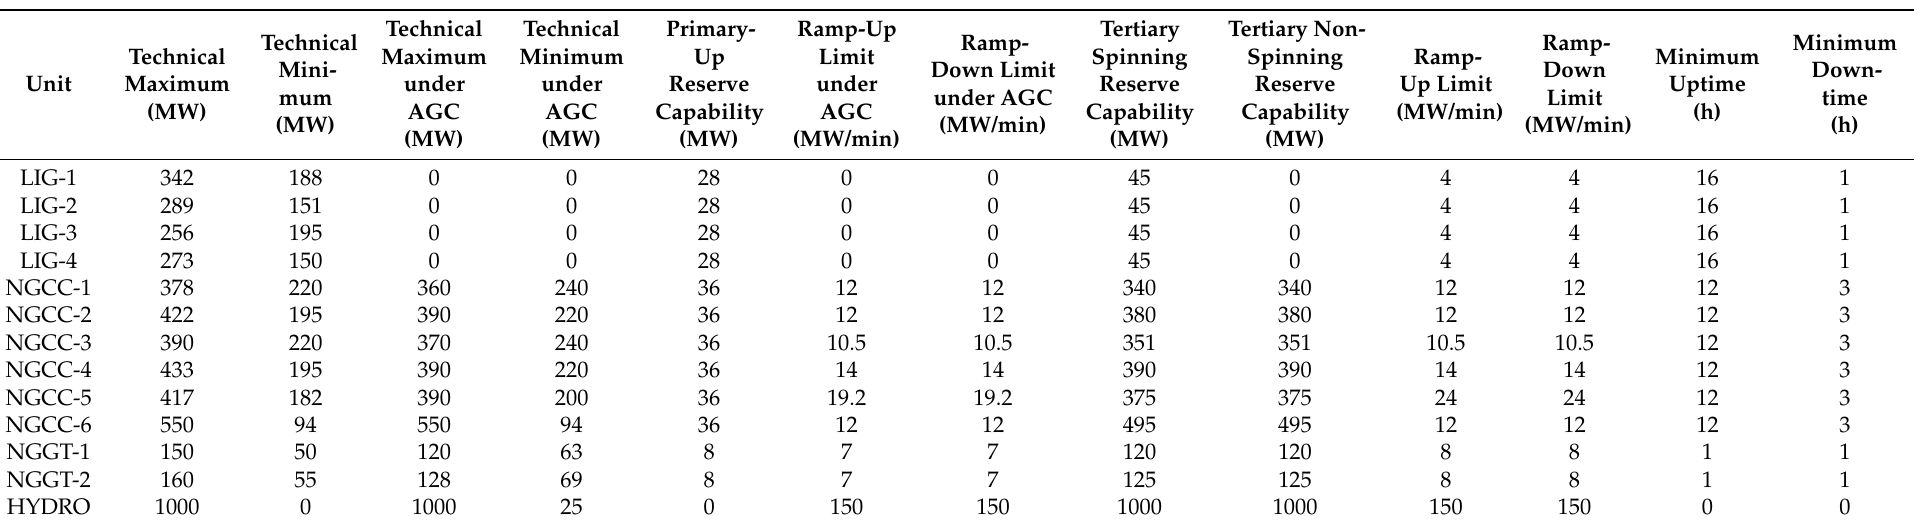
Table 2. Main technical data of the studied power